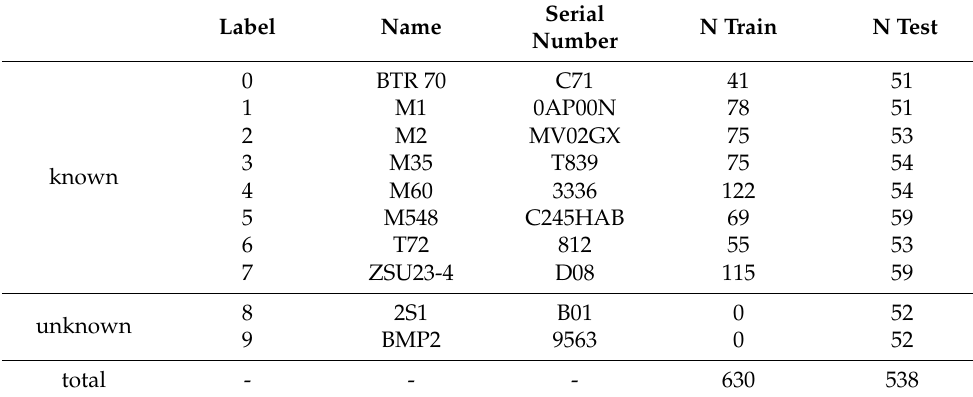
Table 2. MSTAR dataset.